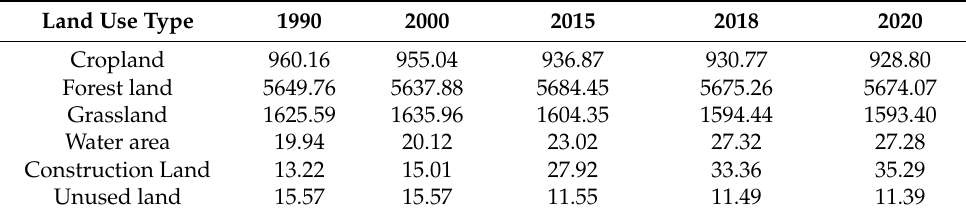
Table 4. Carbon stocks of different land use types in Yunnan Province, 1990–2020 (10 6